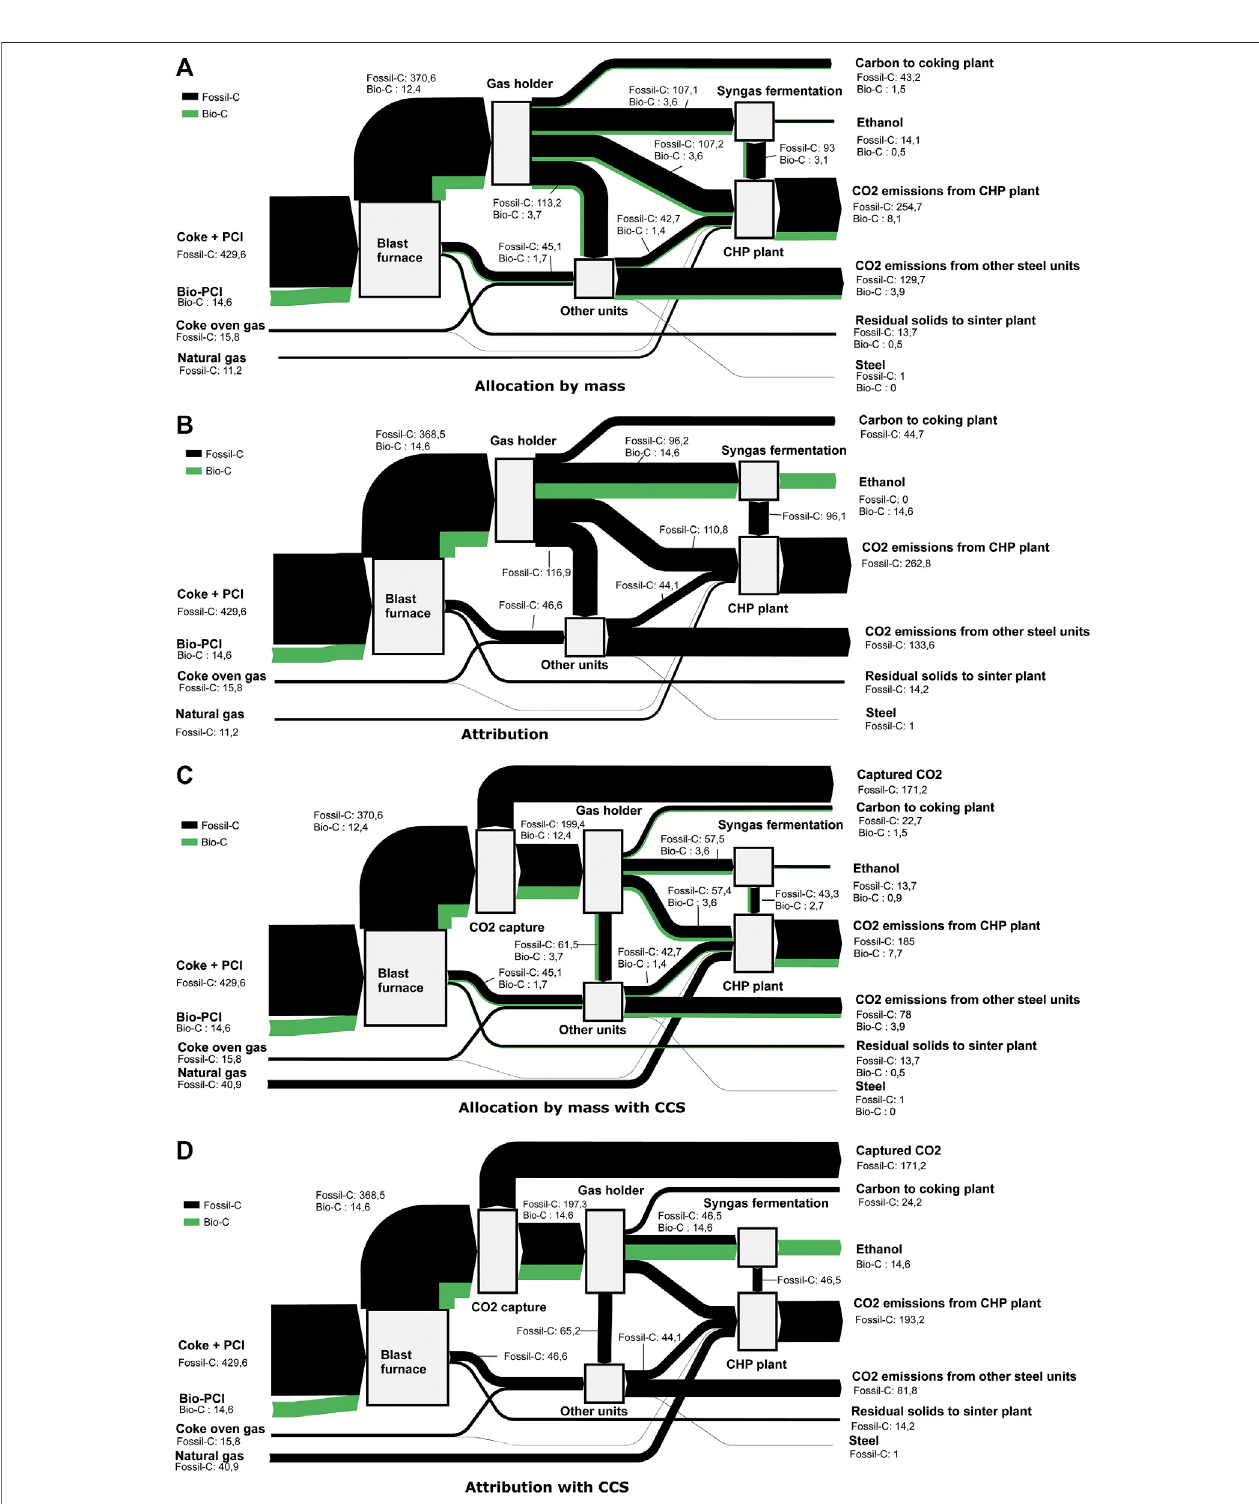
FIGURE7| Flowofbiogeniccarbon(green)throughoutamillwith(A – D)ethanolproduction(C3)and(C,D)CCS(C4).Theallocationbetweenstreamsisgivenby(A, C) allocation by mass and (B, D) attribution. The green arrows are enhanced for visualization purposes (5:1) relative to the black arrows (fossil carbon). The values given are kg of carbon per ton